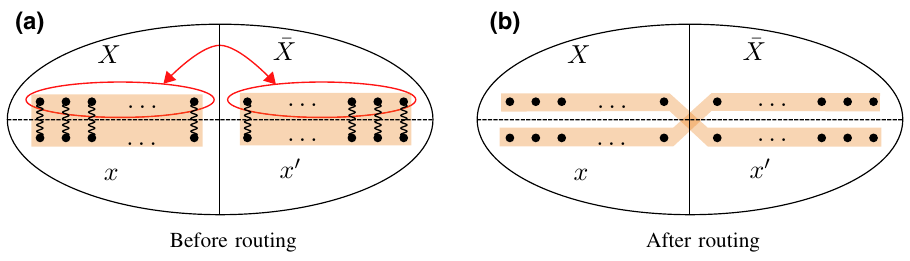
FIG. 3. For the proof of Theorem II.6, we consider a bipartite system consisting of X and ¯ X with | X | ≤ | ¯ X | . The subsystems X and ¯ X consist of qubits represented by vertices and are augmented with ancilla spaces x and x (cid:10) , respectively. To each qubit in X and ¯ X we associate one ancilla in x and x (cid:10) , respectively. We initialize each qubit-ancilla pair in a Bell state (wavy line). The entropy of subsystem Xx is 0. We then perform routing to exchange X with a subset of ¯ X (in red). This increases the entropy of Xx to 2 | X | . We bound the entanglement increase for each layer of gates by twice the maximum matching size in ∂(δ X ) , thereby lower bounding the circuit depth and qrt ( G )